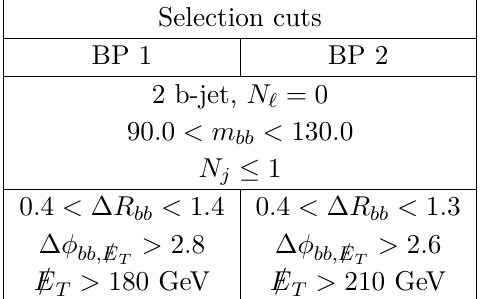
Table 12. The selection cuts optimised in the b ¯ b + /E